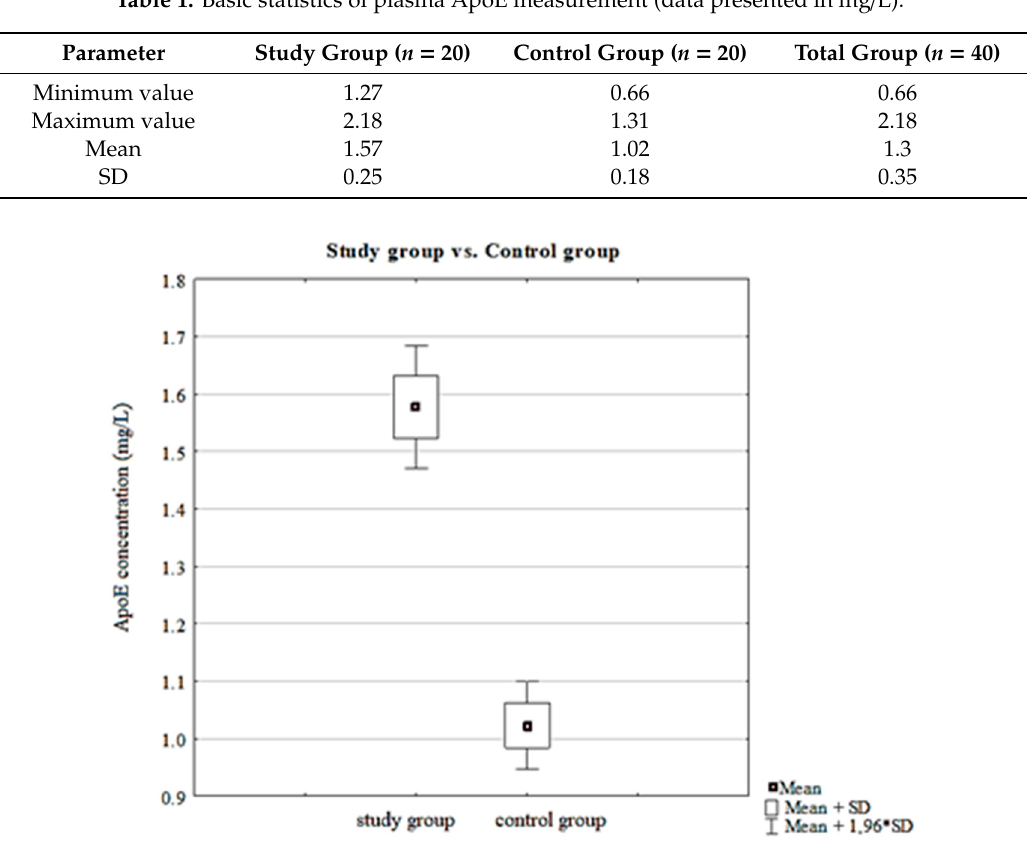
Figure 1. Concentration of apolipoprotein E (ApoE) measurements in study vs. control group. SD, standard deviation.